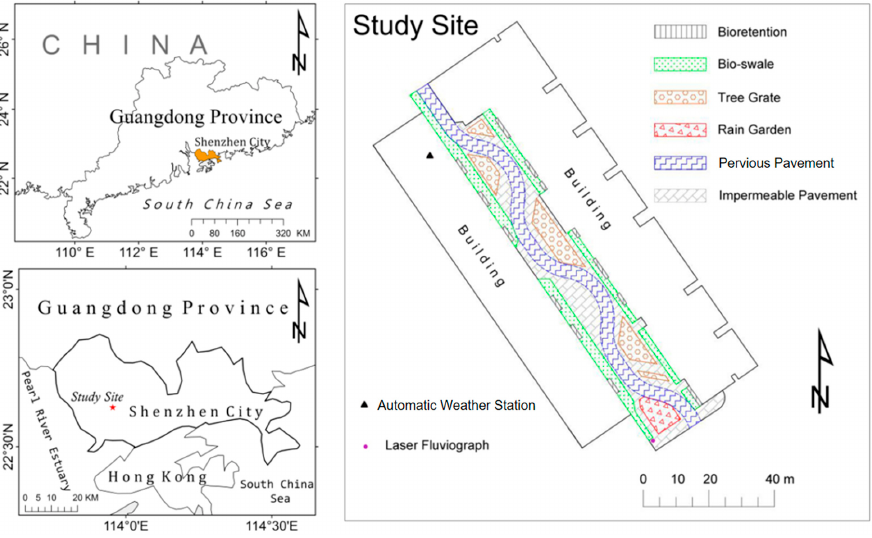
Figure 1. Study Area.